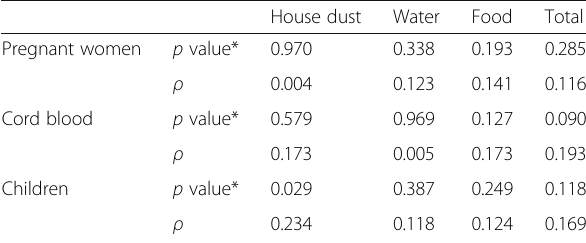
Table 3 Correlations between blood lead concentrations and oral lead exposure level from various sources House